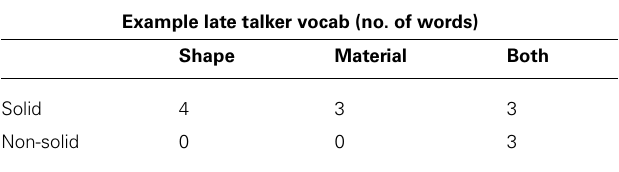
Table 3 | Example of possible vocabulary proportions for a late talker toddler.